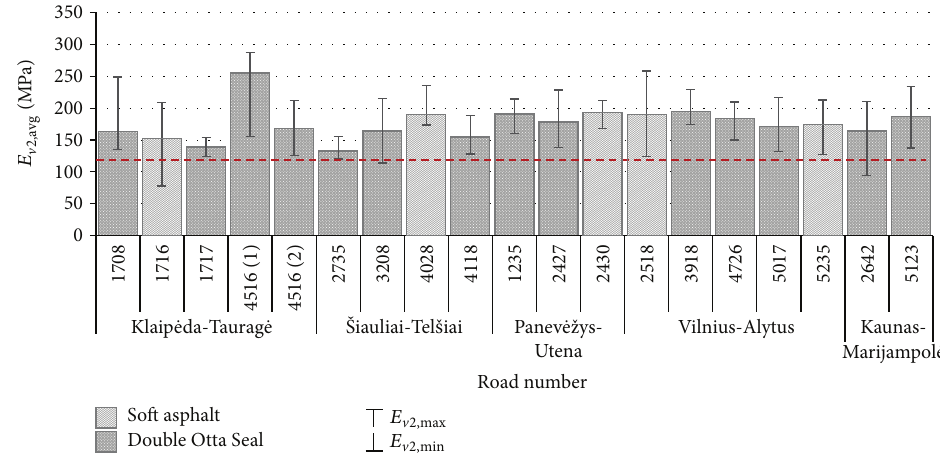
Figure 4: Bearing capacity of the base layer (horizontal hyphenated line shows the required minimum value).